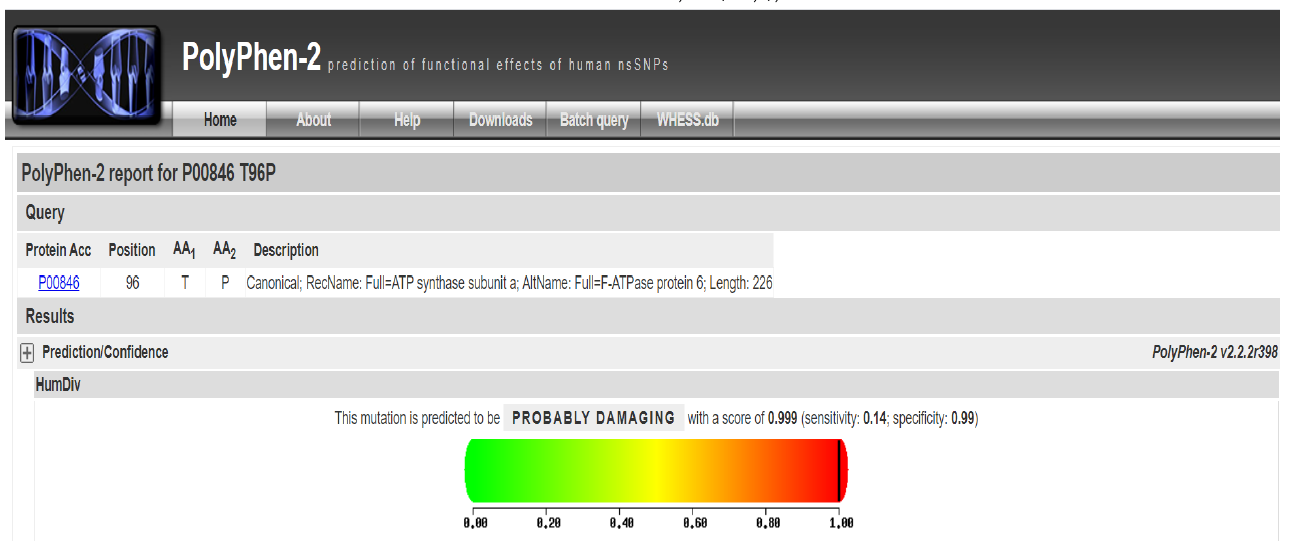
Fig. 2. Polyphe-2 analysis prediction for m.8812 A>C variation indicates a damaging effect on the translated